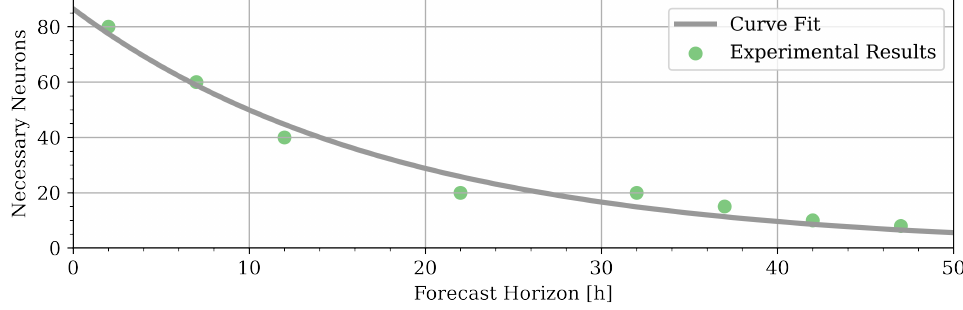
Figure 8. Experimental results and exponential curve fit for the necessary number of hidden neurons in the first hidden layer depending on the forecast